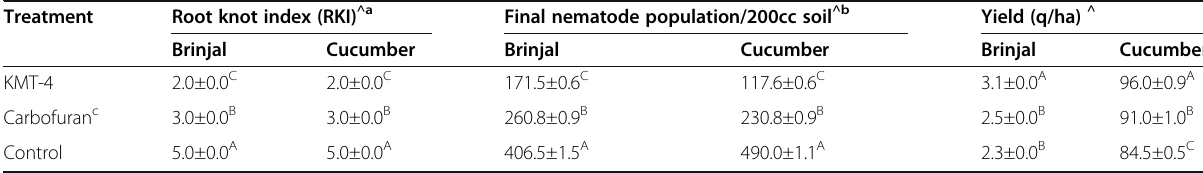
Table 4 Effect of inoculation of Bacillus aryabhattai KMT-4 at farmer ’ s polyhouse at Bhuna (Fatehabad) on brinjal ( Solanum melongena L.) and cucumber ( Cucumis sativus L.) crops during the year 2018 and 2019,